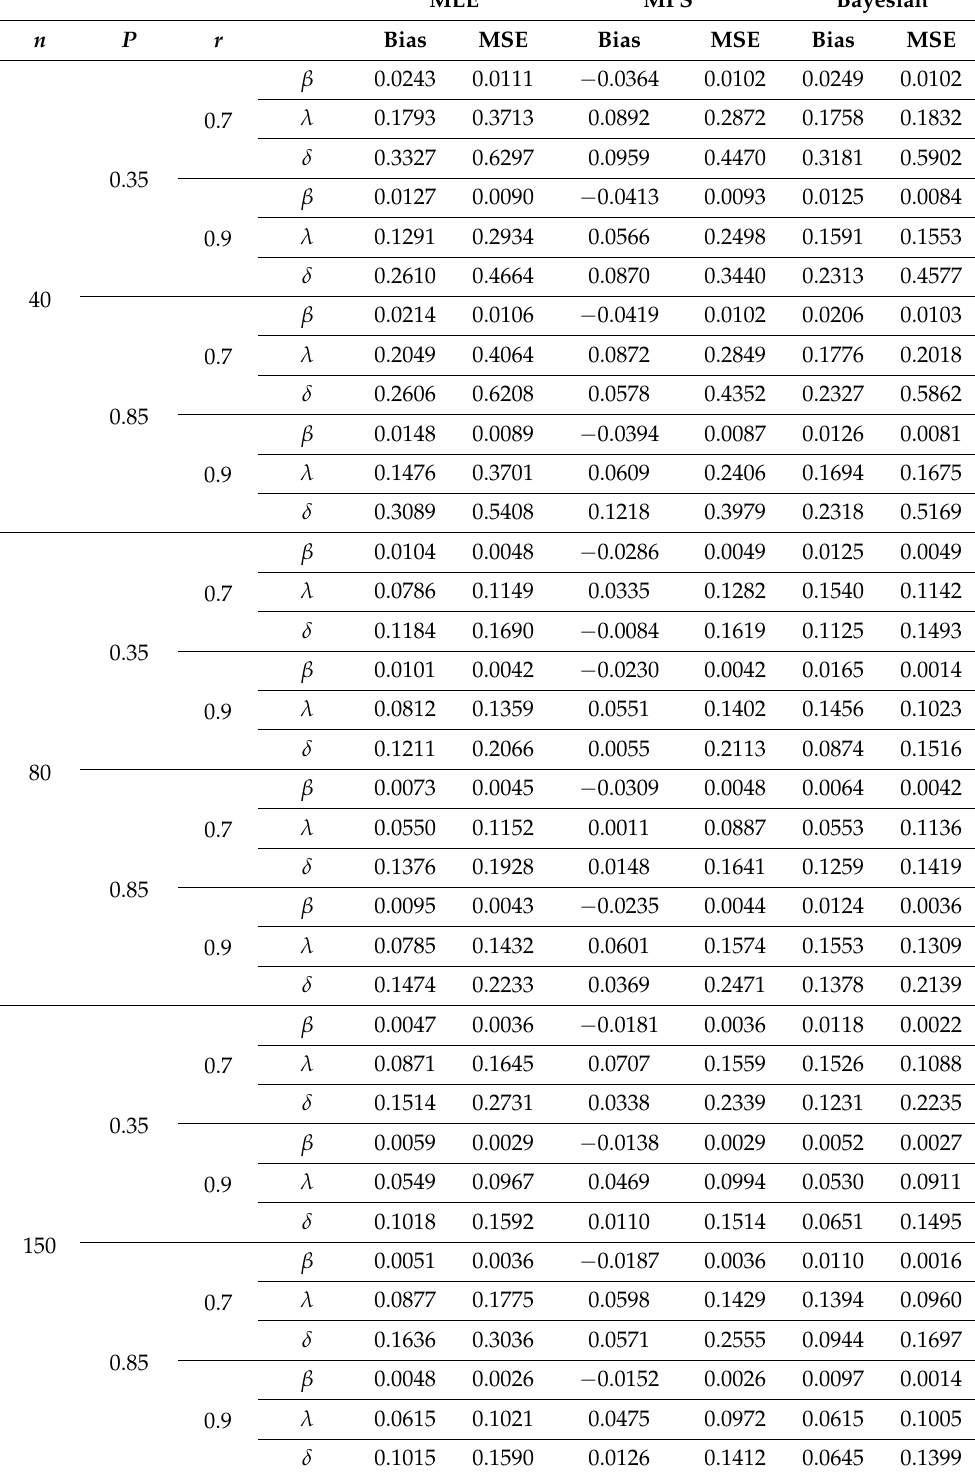
Table 2. The MLE, MPS, and Bayesian of the WE parameters under the PTIICS with random removal for Case